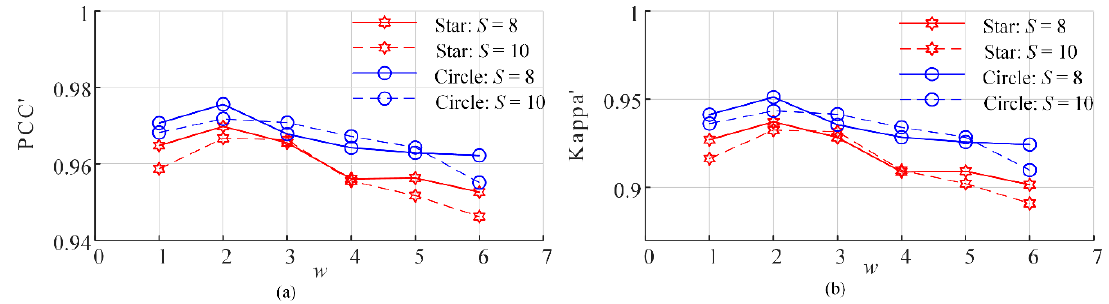
Figure 16. Accuracies of the PSA_MSA1 algorithm under different low attractiveness ranges. ( a ) PCC’ and ( b ) Kappa’.